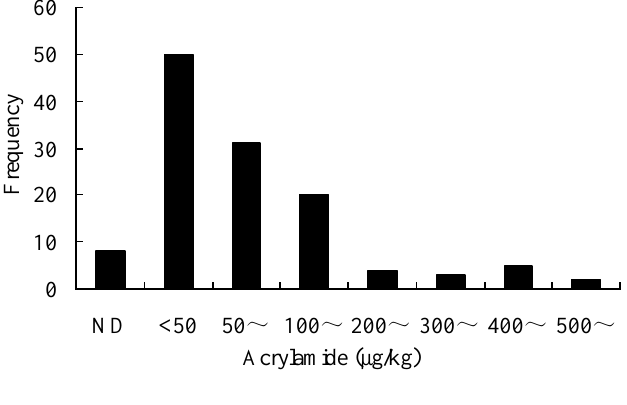
Figure 2. Frequency distribution of acrylamide content in food.